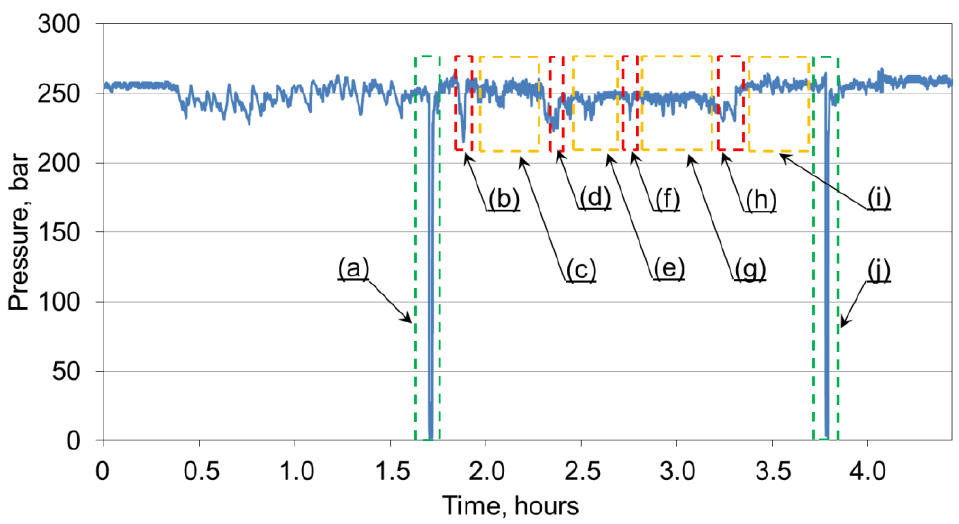
Figure 8. Analysis of the pressure charging function with the time of moving the section to a new position.